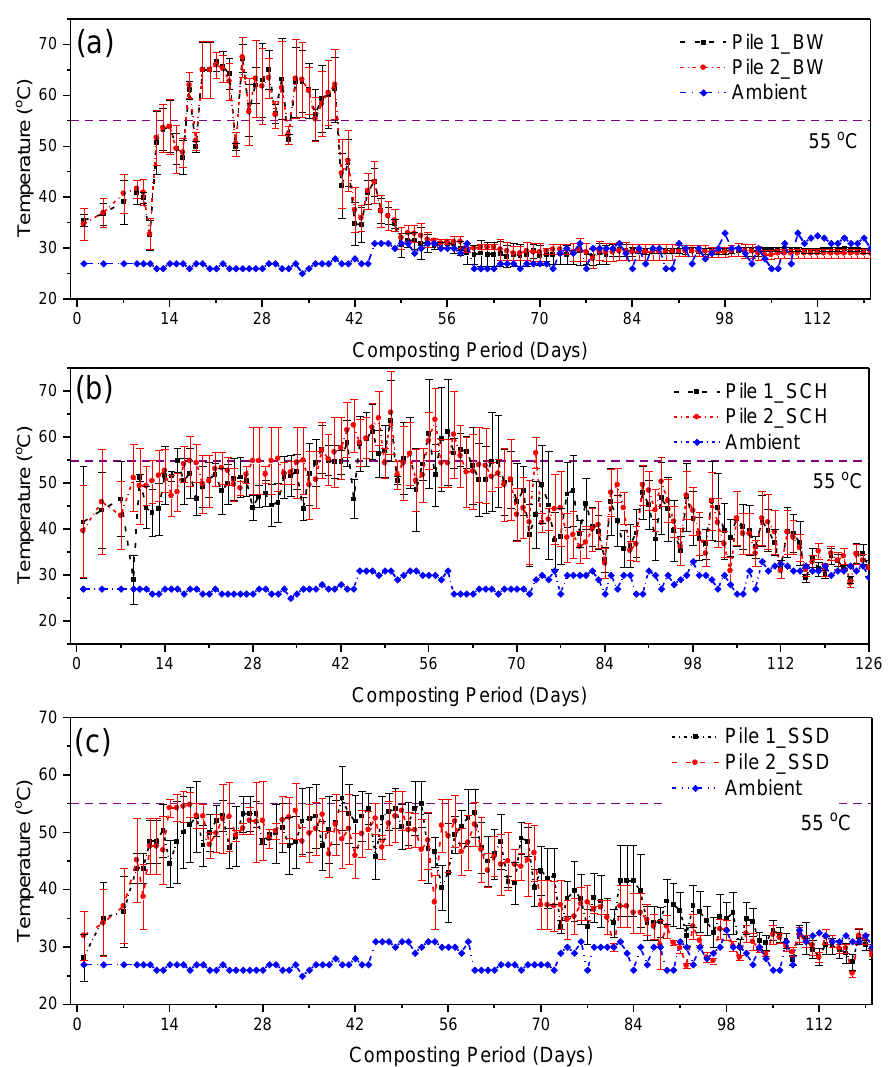
Figure 1. Temperature evolution during composting of faecal sludge-FS with: ( a ) brewery waste-SBW; ( b ) coffee husks-SCH; and ( c ) sawdust-SSD. In ( a – c ) error bars represent the standard deviation of the bottom, centre, left side, and right-side pile temperatures.